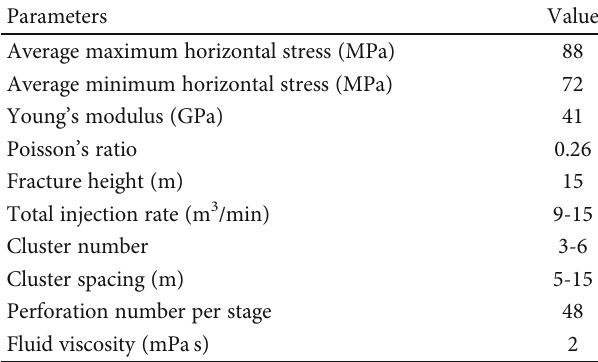
Table 2: The main basic model